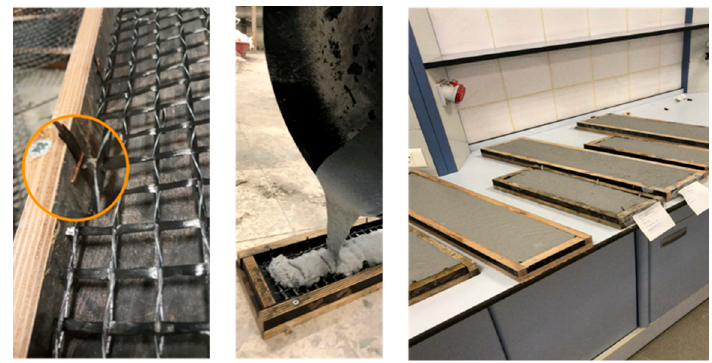
Figure 2. Production stages of composites produced using the M120 matrix.